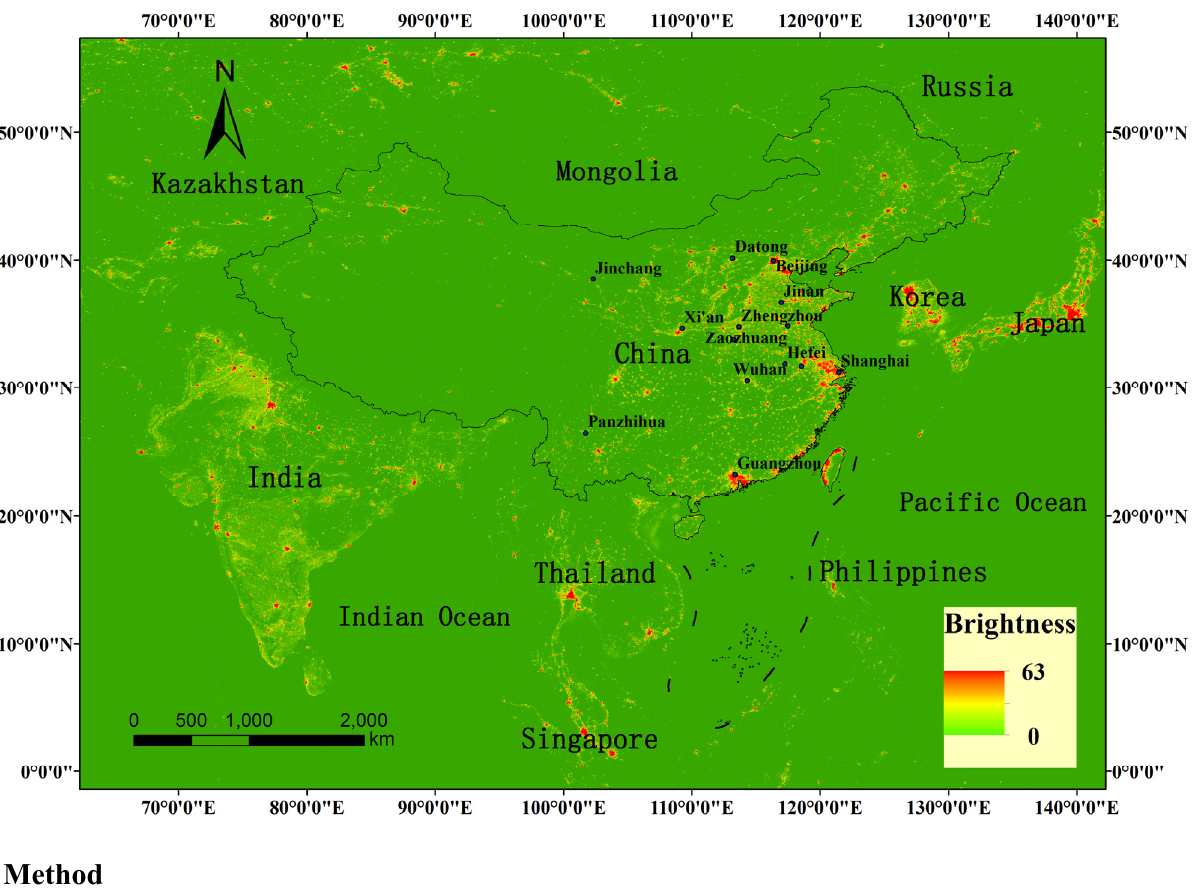
Figure 1. Location of China and DMSP/OLS (F18 satellite) nighttime light imagery in